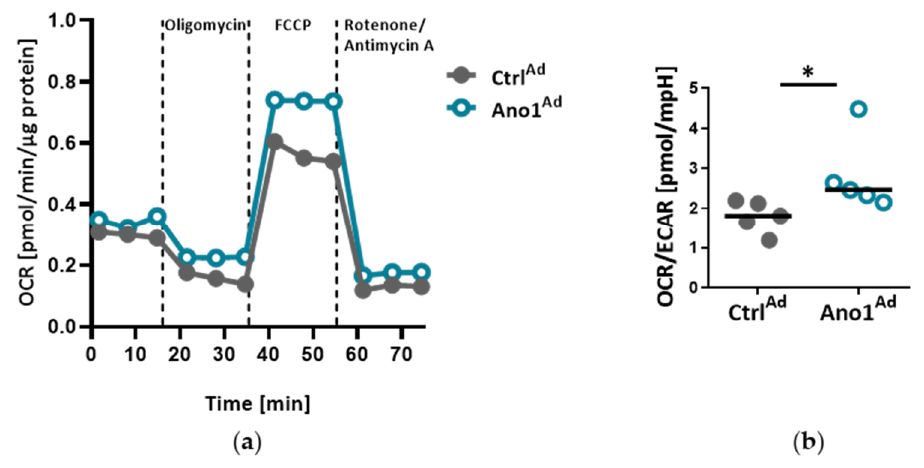
14 of 26 Figure 4. TMEM16A-mediated membrane depolarization disrupts Ca 2+ dynamics of human PAECs. ( a ) Fluorometric measurements indicating shift in relative resting membrane potential (E m ) of donor PAECs infected with Ctrl Ad or Ano1 Ad using DiBAC 4 (3) dye. ( b ) Representative traces depict changes in intracellular Ca 2+ detected in PAECs transfected with Ctrl Ad or Ano1 Ad . ( c – e ) The effect